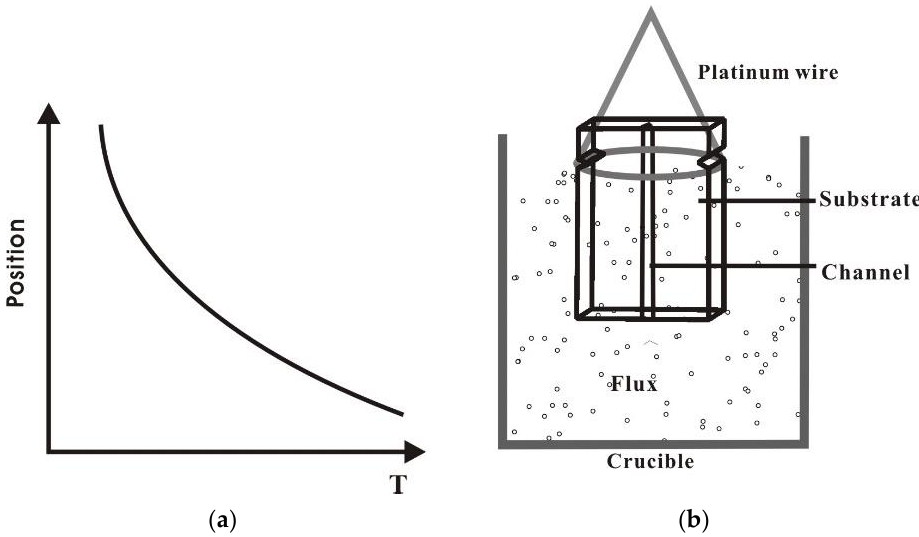
Figure 15. ( a ) Temperature profile in the crucible as a function of position. ( b ) Schematic of the crystal growth furnace layout for liquid phase epitaxial growth of channel waveguides.